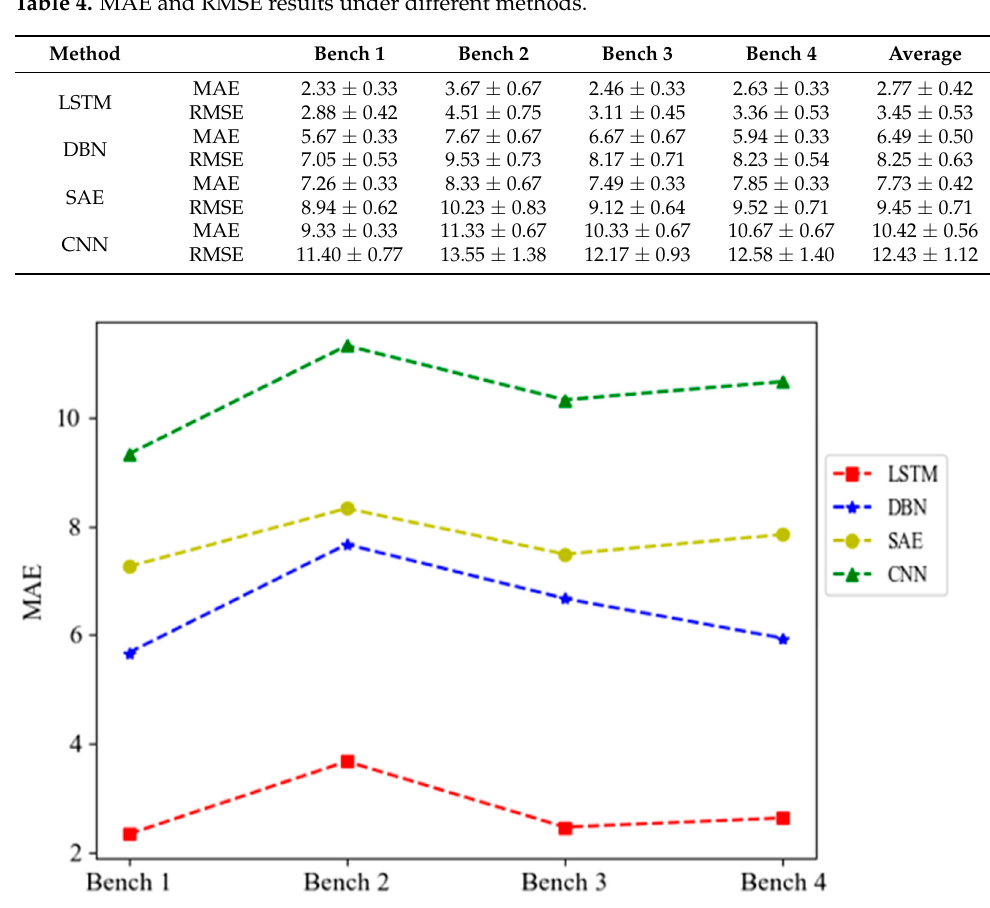
Figure 9. MAE comparison under different methods.